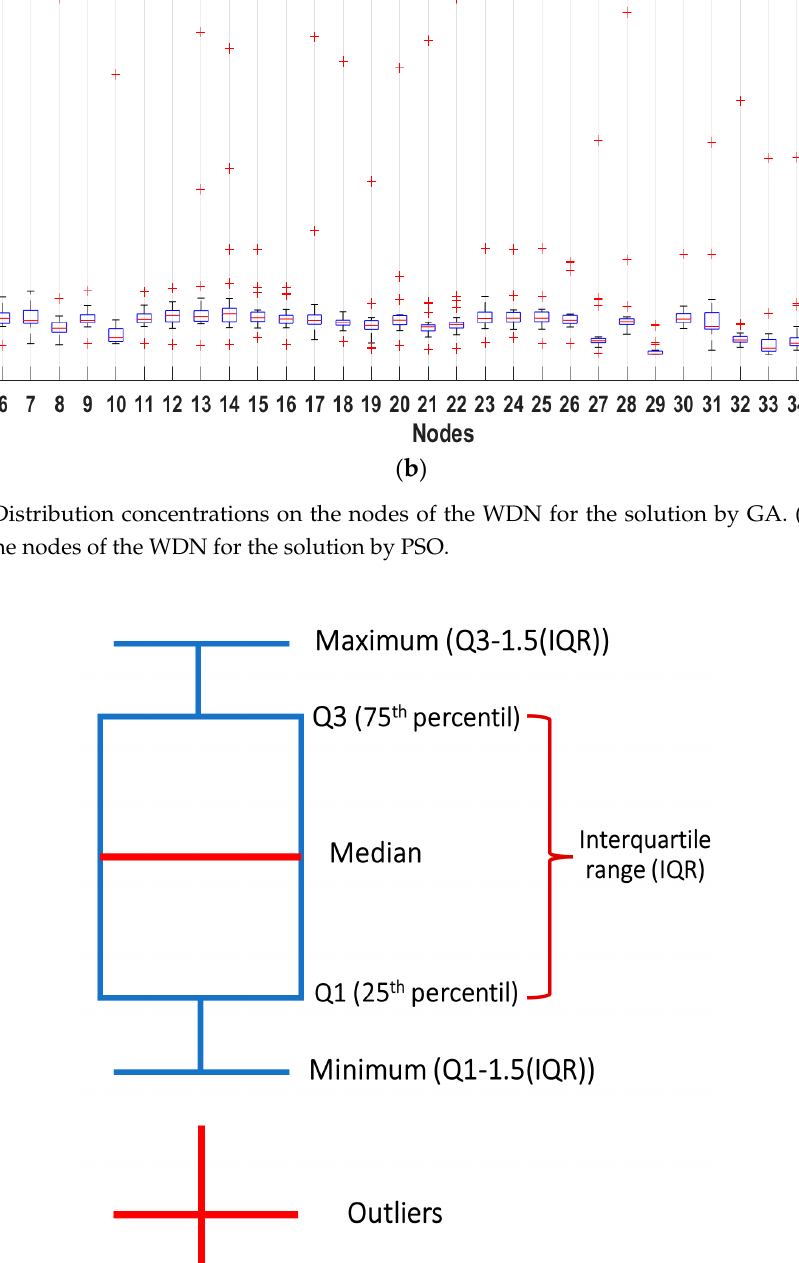
Figure 10. Box and whisker symbology.